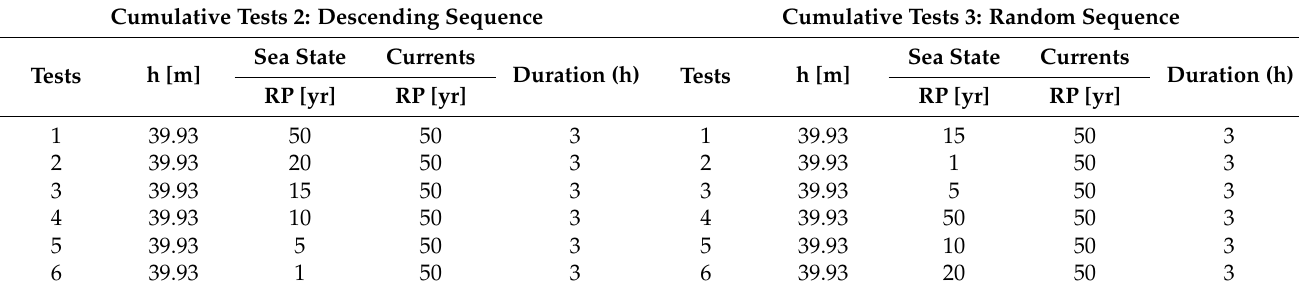
Table 2. (Left) Cumulative tests 2, with a descending sequence. (Right) Cumulative tests 3, with a random sequence. Cumulative Tests 2: Descending